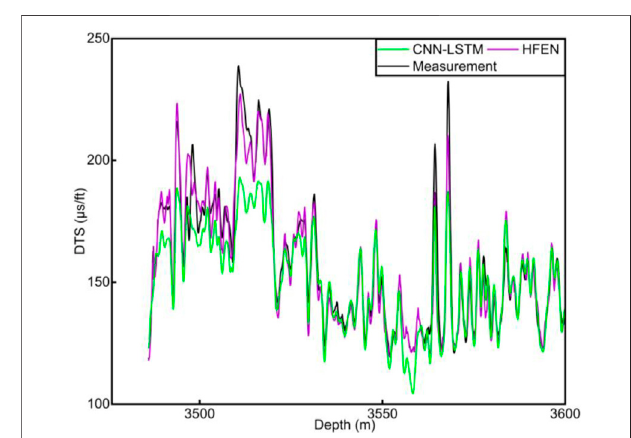
FIGURE 14 | HFEN vs. Measurement in well